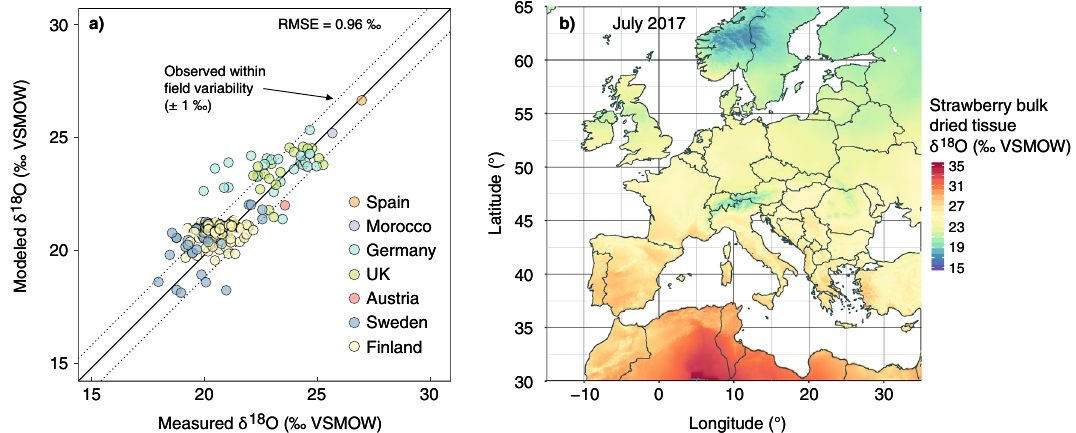
Figure 3. Results of the simulation of berry bulk dried δ 18 O values using plant physiological isotope models. ( a ) The modeled bulk dried tissue δ 18 O values obtained from the model that was parameterized with general data for berries plotted against measured authentic bulk dried tissue reference samples δ 18 O values (n = 154; RMSE = 0.96 ‰). Solid line represents the 1:1-line, the dashed lines show the 95% quantile of the observed within field variability of strawberry δ 18 O bulk dried tissue values. ( b ) Map of Europe showing the expected spatial distribution of bulk dried tissue δ 18 O values of strawberries, in this example collected in July 2017. The map was created using the software R, version 3.5.3 (https:// www.r- proje ct.